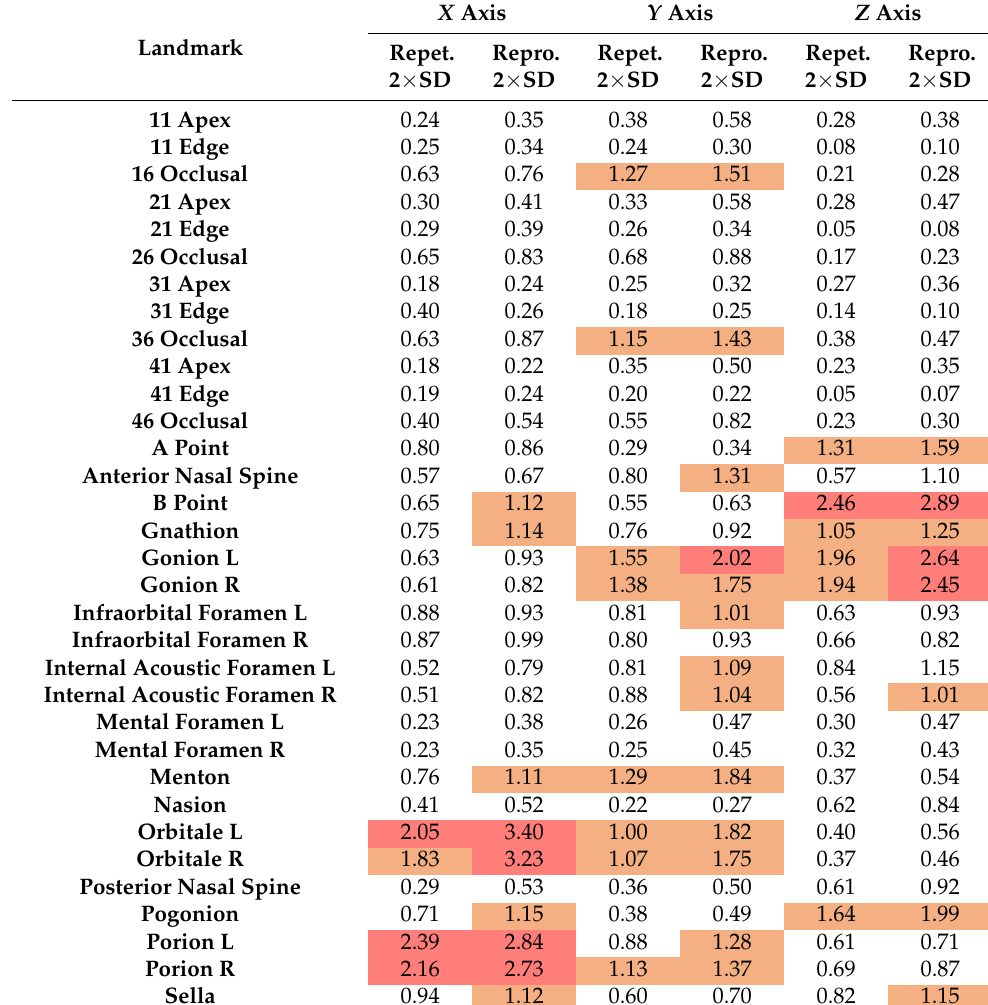
Table 4. 95% confidence interval (2 × SD) of repeatability and reproducibility of the landmarks (mm), following the ISO 5725 standard. Values between 1 and 2 mm are highlighted in orange, and values superior to 2 mm are highlighted in